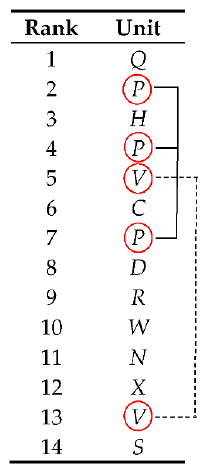
Figure 5. Ranking with multiple contradictions.